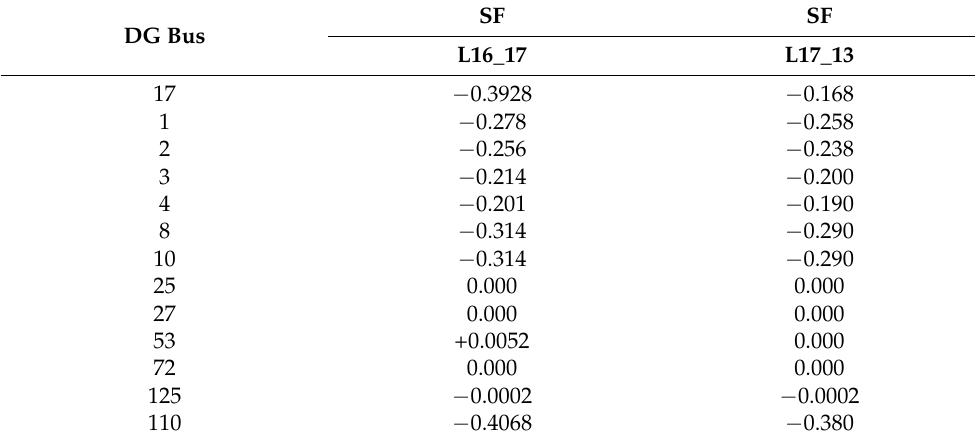
Table 10. Feasible buses in the practical grid system for selecting optimal buses for DG penetration through the developed algorithm during the outage of L91-4003.